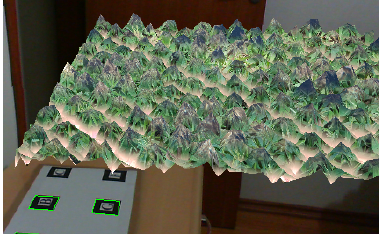
Fig. 6. A possible initial terrain generated with Perlin noise.